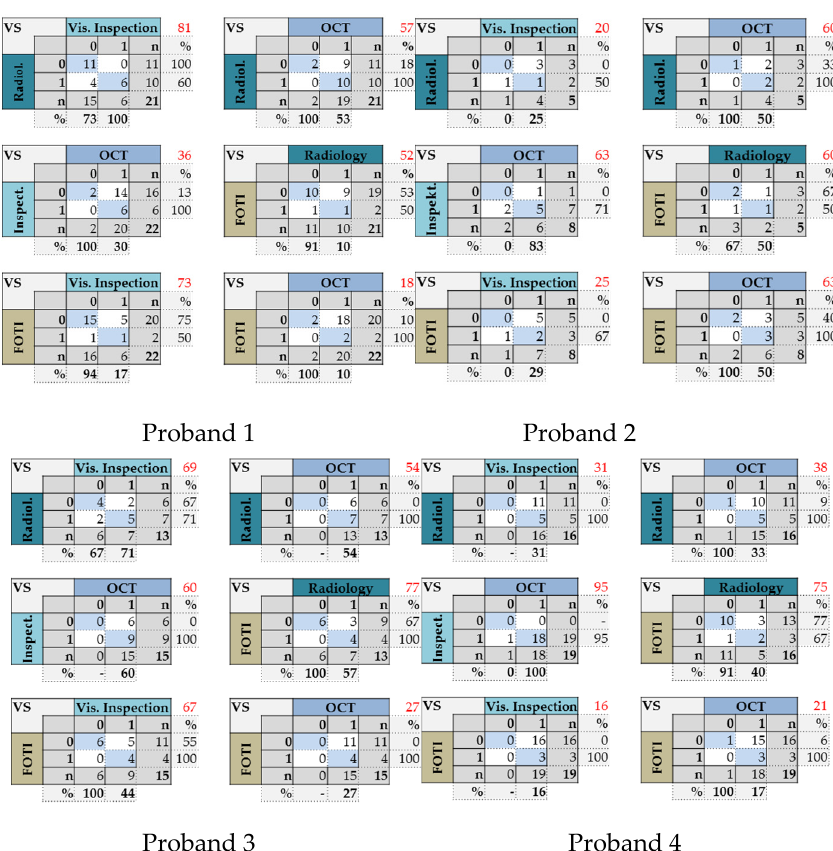
Figure 7. Contingency tables. Pairwise comparison of the four caries detection methods. The red marked percentages indicate the agreement of two methods for both scores 0 and 1. There were fewer proximal areas that could be evaluated with radiography, as some could not be assessed due to superimpositions.